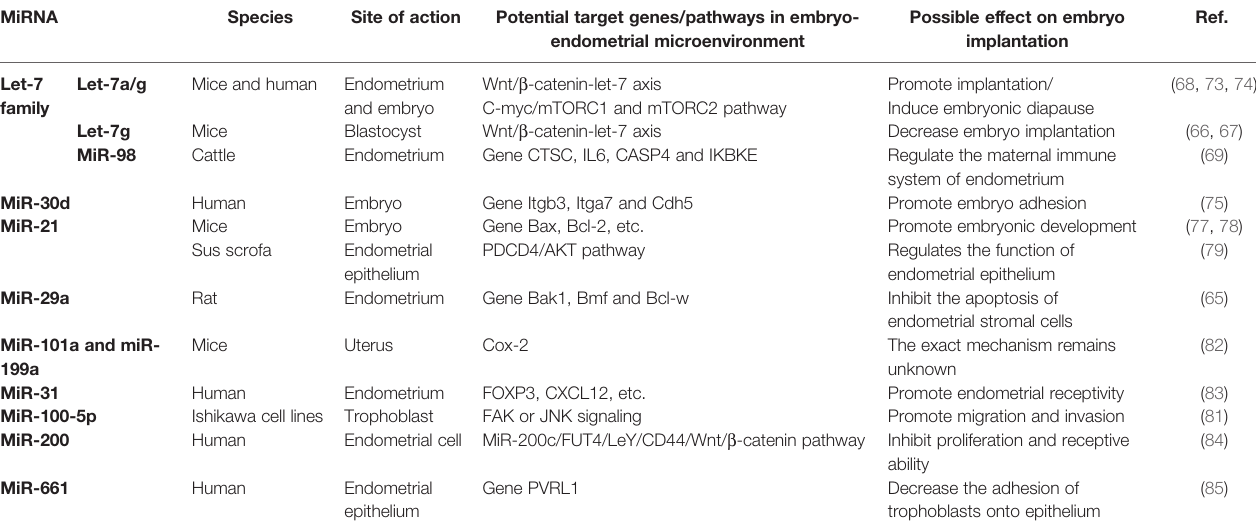
TABLE 2 | The reported miRNA cargos and their implication in embryo